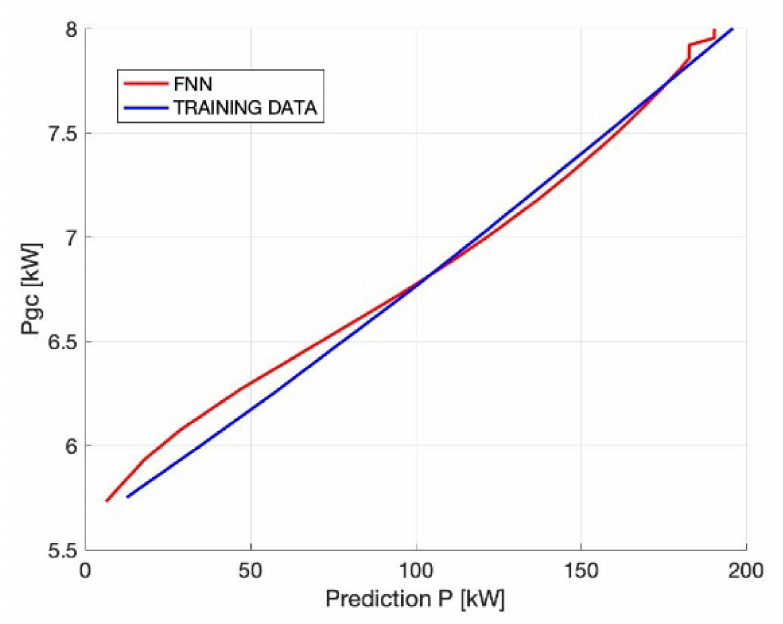
Figure 26. Compilation of the training data with the machine response, scenario